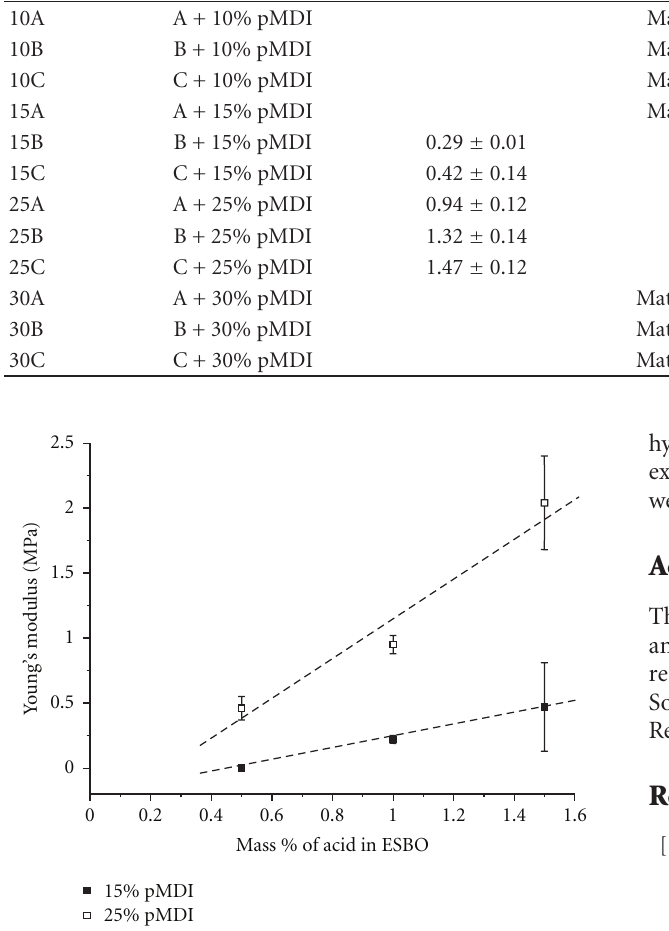
Figure 4: E ff ect of the amount of o- H 3 PO 4 on Young’s modulus of bioelastomers with 15% and 25% pMDI